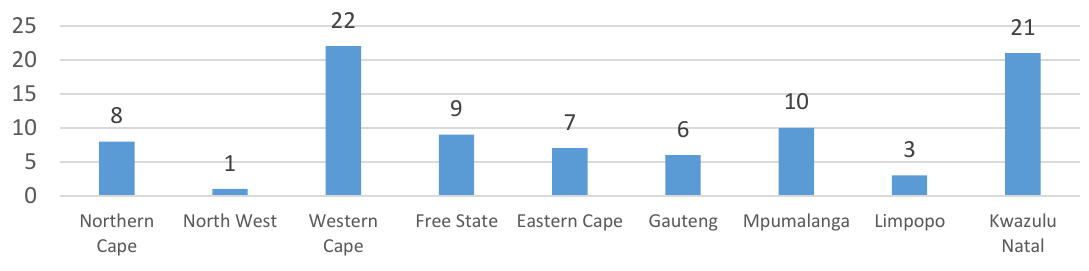
Figure 2. Geographical and biographical profile of participants and respondents Participant profile: Target group 1